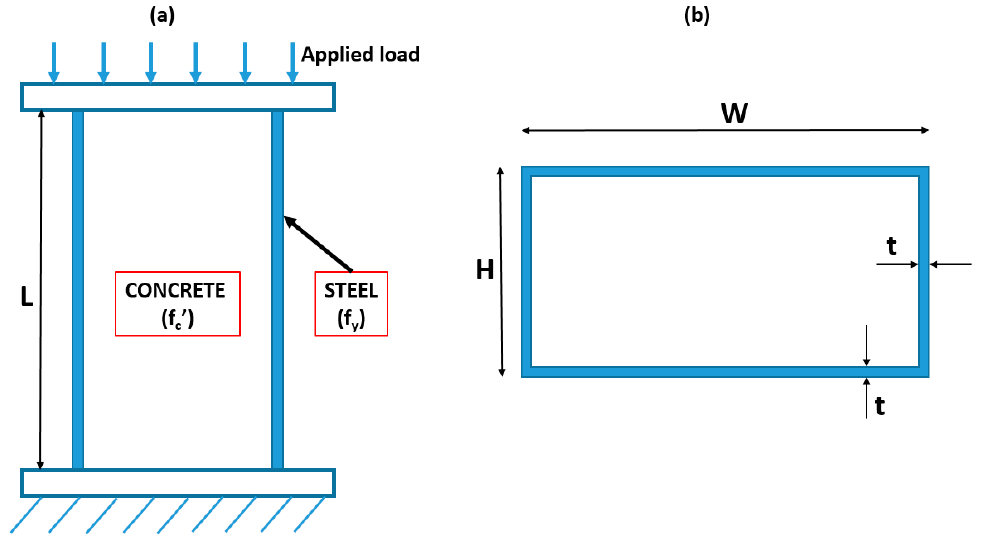
Figure 1. Schematic diagram of the compression test for concrete filled steel tubes (CFSTs): ( a ) front view; ( b ) cross-section view of the sample.